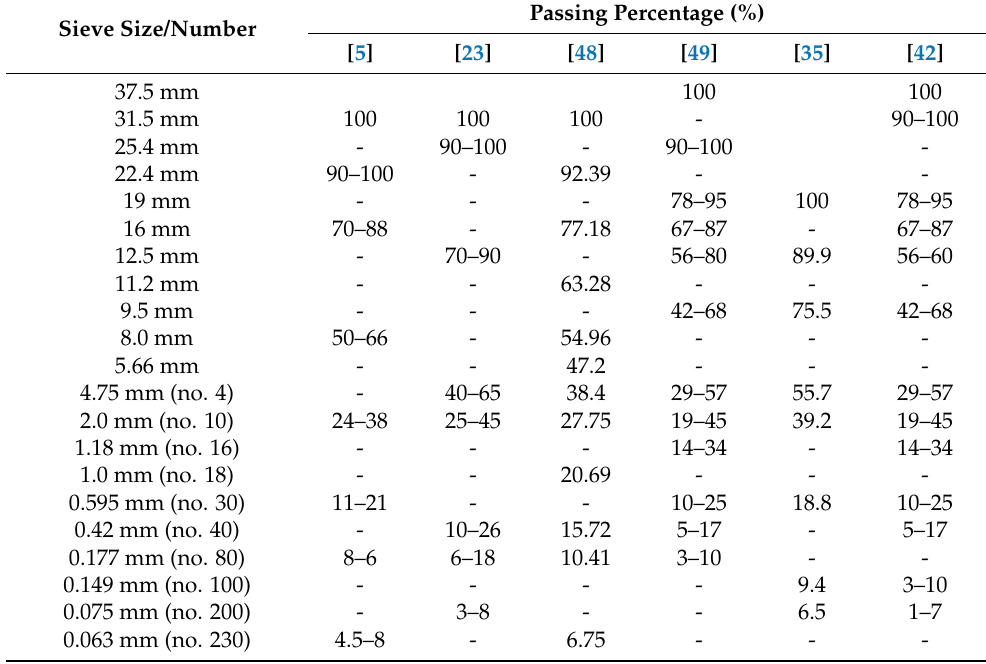
Table 6. Aggregate gradation for asphalt mixtures on